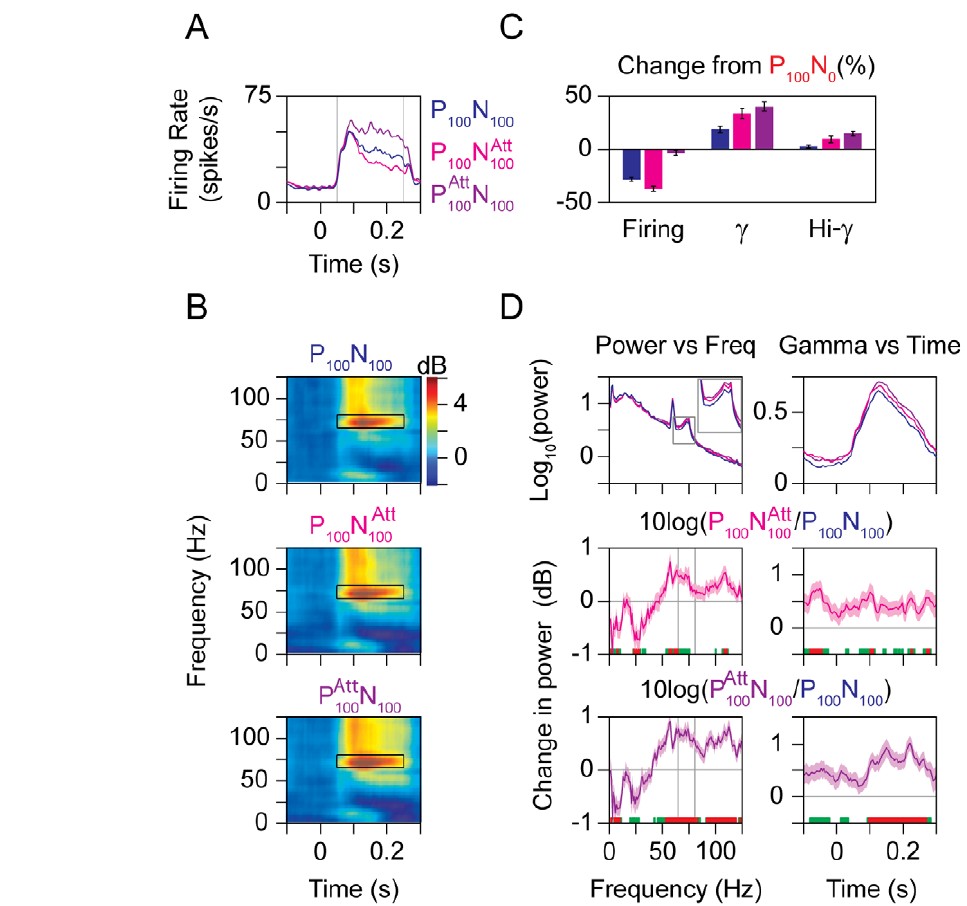
Figure 6. Attention increases gamma power. (A) Average firing rates of 96 neurons when a preferred and null stimulus was presented at 100% contrast inside the receptive field, while the monkeys attended to a stimulus outside the receptive field moving at an intermediate direction (P 100 N 100 ), the null stimulus inside the receptive field (P 100 N 100Att ), or the preferred stimulus (P 100Att N 100 ) inside the receptive field. (B) Time-frequency power difference spectra for the three conditions described in (A). (C) Percent change in firing rates (Firing), gamma power ( c ), and high-gamma power (Hi- c ) relative to the P 100 N 0 condition, for the three attentional conditions described in (A). (D) LFP power as a function of frequency (left column) and gamma power as a function of time (right column). The top plot shows the raw power for different attention conditions described in (A). The middle plot shows the comparison between P 100 N 100Att versus P 100 N 100 , while the bottom plot shows the comparison between P 100Att N 100 versus P 100 N 100 . Stimuli for these plots are identical, so the difference is purely due to attention. Same convention as in Figure 4B and 4D. (bottom row, right column). Results obtained from multitaper analysis were very similar (not shown).